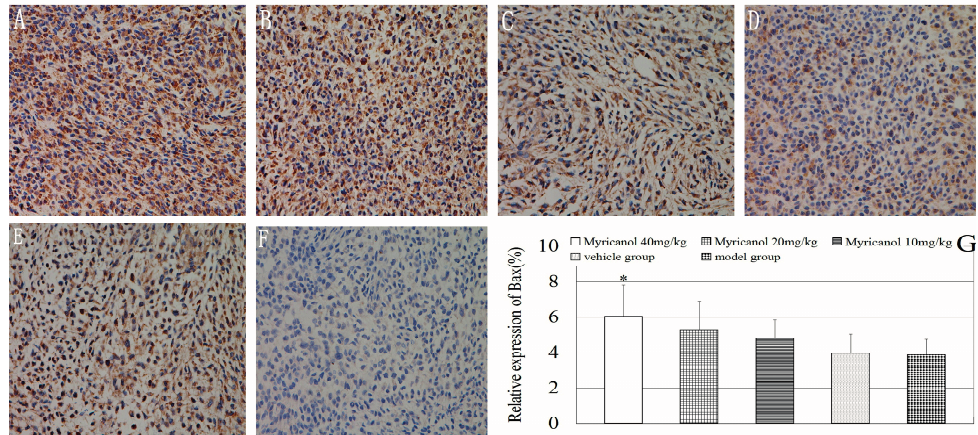
Figure 3. Immunohistochemical detection of BAX protein in A549 cells (magnification of 400×). The relative expression of Bax was determined by NIS-Elements D 3.2 image analysis system. ( A ) Myricanol with 40 mg/kg; ( B ) myricanol with 20 mg/kg; ( C ) myricanol with 10 mg/kg; ( D ) vehicle control group; ( E ) tumor model group; and ( F ) isotype control. The yellow and brown particles represent positive BAX expression; ( G ) Quantification of protein expressions in different groups by IHC. * Compared with the vehicle group, p < 0.05.